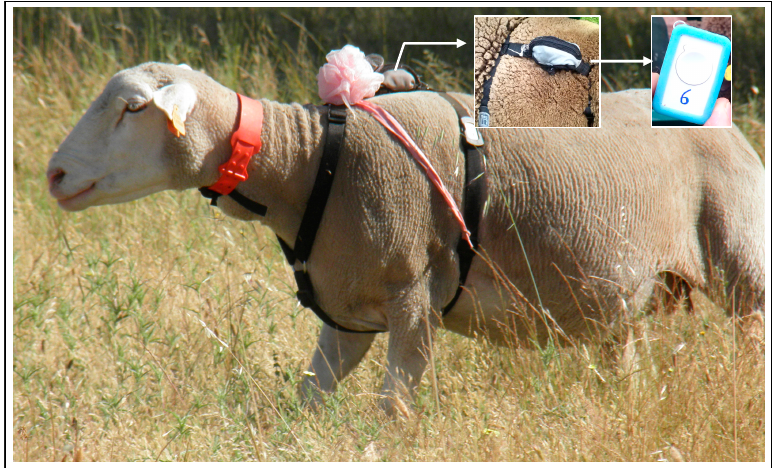
Figure 10. Animal GPS receiver “CatTrack TM ” used to monitor the grazing patterns.